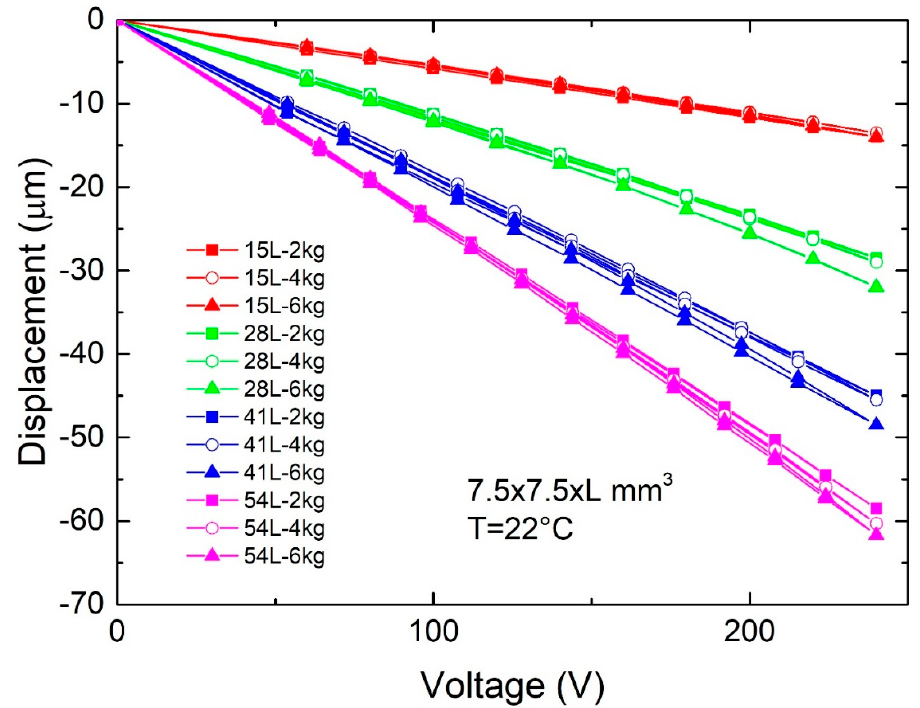
Figure 6. Displacement responses at 22 °C of square-pipe stake actuators of 7.5 × 7.5 mm 2 overall cross-section and 4 different overall lengths (L = 15, 28, 41 and 54 mm) under different axial loads. The applied voltage was increased to the maximum of 240 V at a rate of 20 V per 0.5 s interval and then reduced to nil voltage at the same rate.